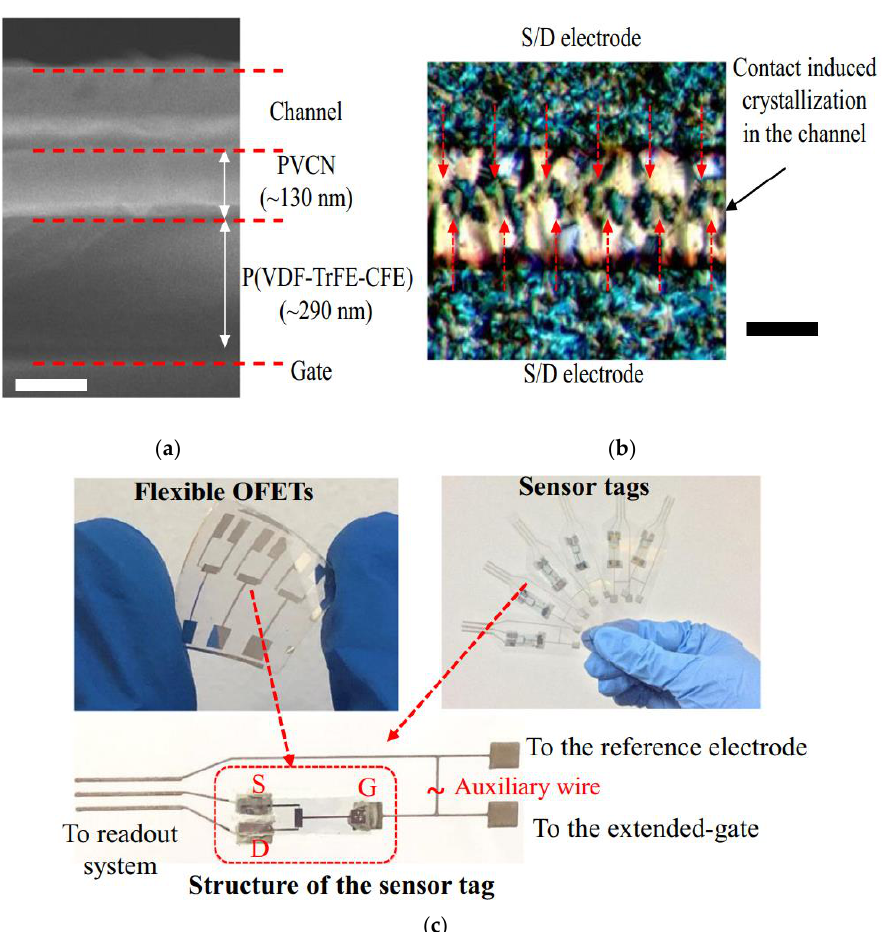
Figure 13. ( a ) Cross-sectional SEM image exhibiting the material stacking of OFET; ( b ) polarized optical micrograph of the OFET depicting the contact-induced crystallization in the channel with perfluorobenzenethiol-modified silver source and drain electrodes; ( c ) fabricated OFETs and the sensor tag images depicting the extended-gate sensing and reference electrode. Reproduced from